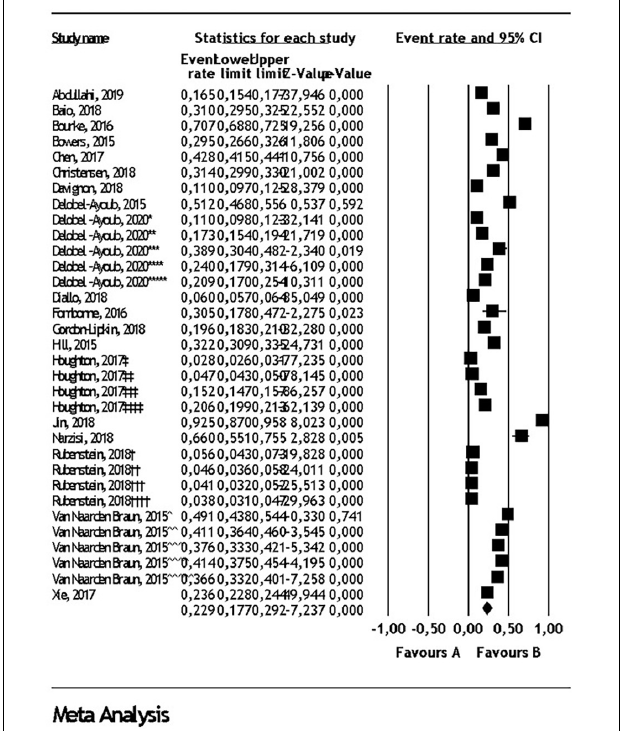
FIGURE 2 | Intellectual disability comorbidity in autism spectrum disorder. Diamond represents the random effect model analysis result for the meta-analysis of 33 subgroups given in 17 studies (*: Denmark (2006-2008), **: Finland (2006-2008), ***: Southwest France (2007), ****: Southeast France (2007), *****: Iceland (2006-2008), † : 2002 ADDM data, †† : 2006 ADDM data, ††† : 2008 ADDM data, †††† : 2010 ADDM data, ‡ : 5-11 years old in commercial data, ‡‡ : 12-17 years old in commercial data, ‡‡‡ : 5-11 years old in Medicaid data, ‡‡‡‡ : 12-17 years old in Medicaid data, ˆ: 2002 MADDSP data, ˆˆ: 2004 MADDSP data, ˆˆˆ: 2006 MADDSP data, ˆˆˆˆ: 2008 MADDSP data, ˆˆˆˆˆ: 2010 MADDSP